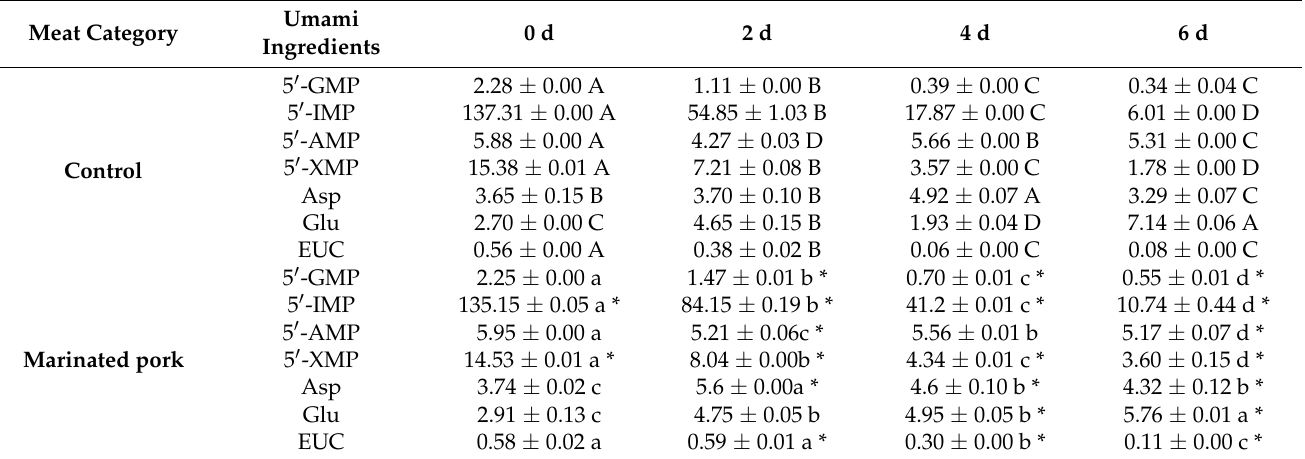
Table 1. The umami amino acids and the nucleotides in the marinated pork and the control (mg/100